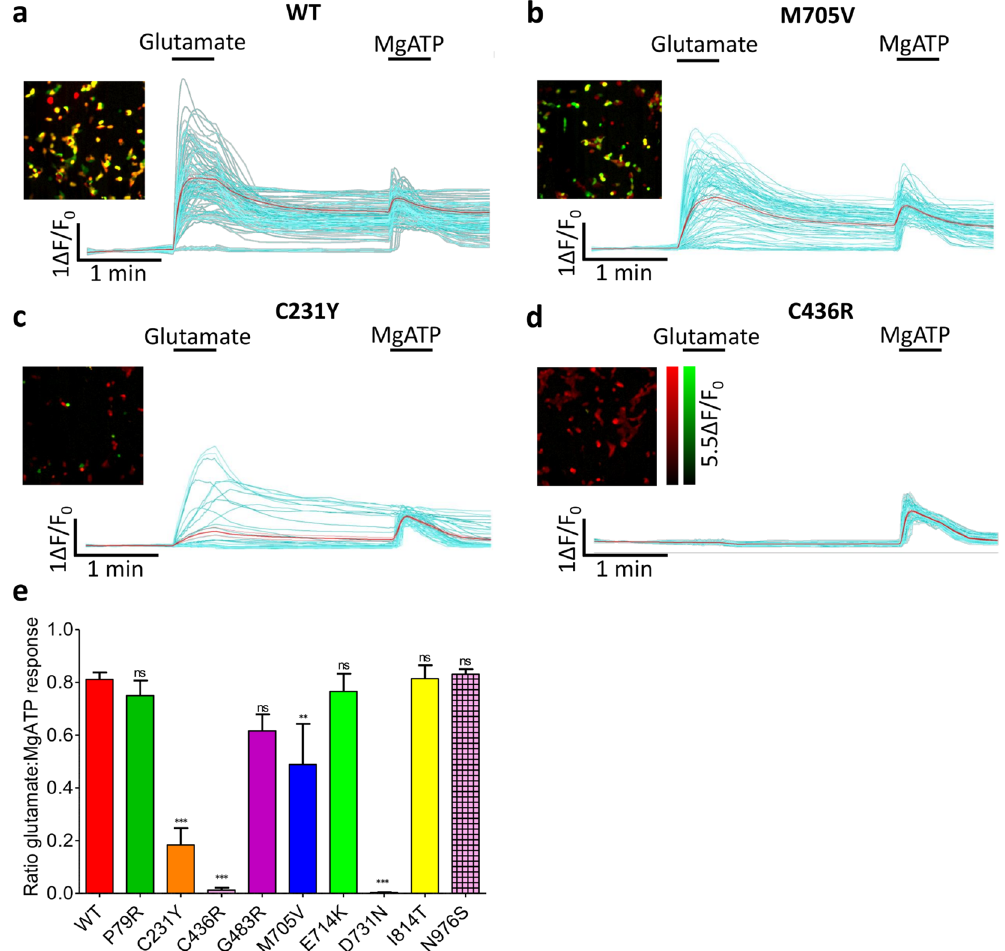
Figure 4. GRIN2A mutations alter the number of cells responding to glutamate. ( a–d ) Each panel contains pseudocolour images of HEK cells transfected with WT or mutant GRIN2A showing co-localisation of responses to application of 100 µ M glutamate + 30 µ M glycine (green - activation of surface-expressing GluN2A receptors) and subsequently 100 µ M MgATP (red - activation of endogenous P2Y receptors). Panels also show single-cell traces from the same experiment, indicating the different effects of these agonists on cells transfected with ( a ) WT, ( b ) M705V, ( c ) C231Y or ( d ) C436R mutants. Individual cell traces displayed in cyan and the mean response shown in red. ( e ) Ratio of the number of transfected HEK cells responding to 100 µ M glutamate + 30 µ M glycine subsequent to 100 µ M MgATP. Dunnett’s corrected one-way ANOVA compared to WT, ** p < 0.01, *** p < 0.001, ns = non-significant. Data averaged from n = 12 wells, 3 × 10 4 cells/well, for each construct over 2 assays. Error bars ±